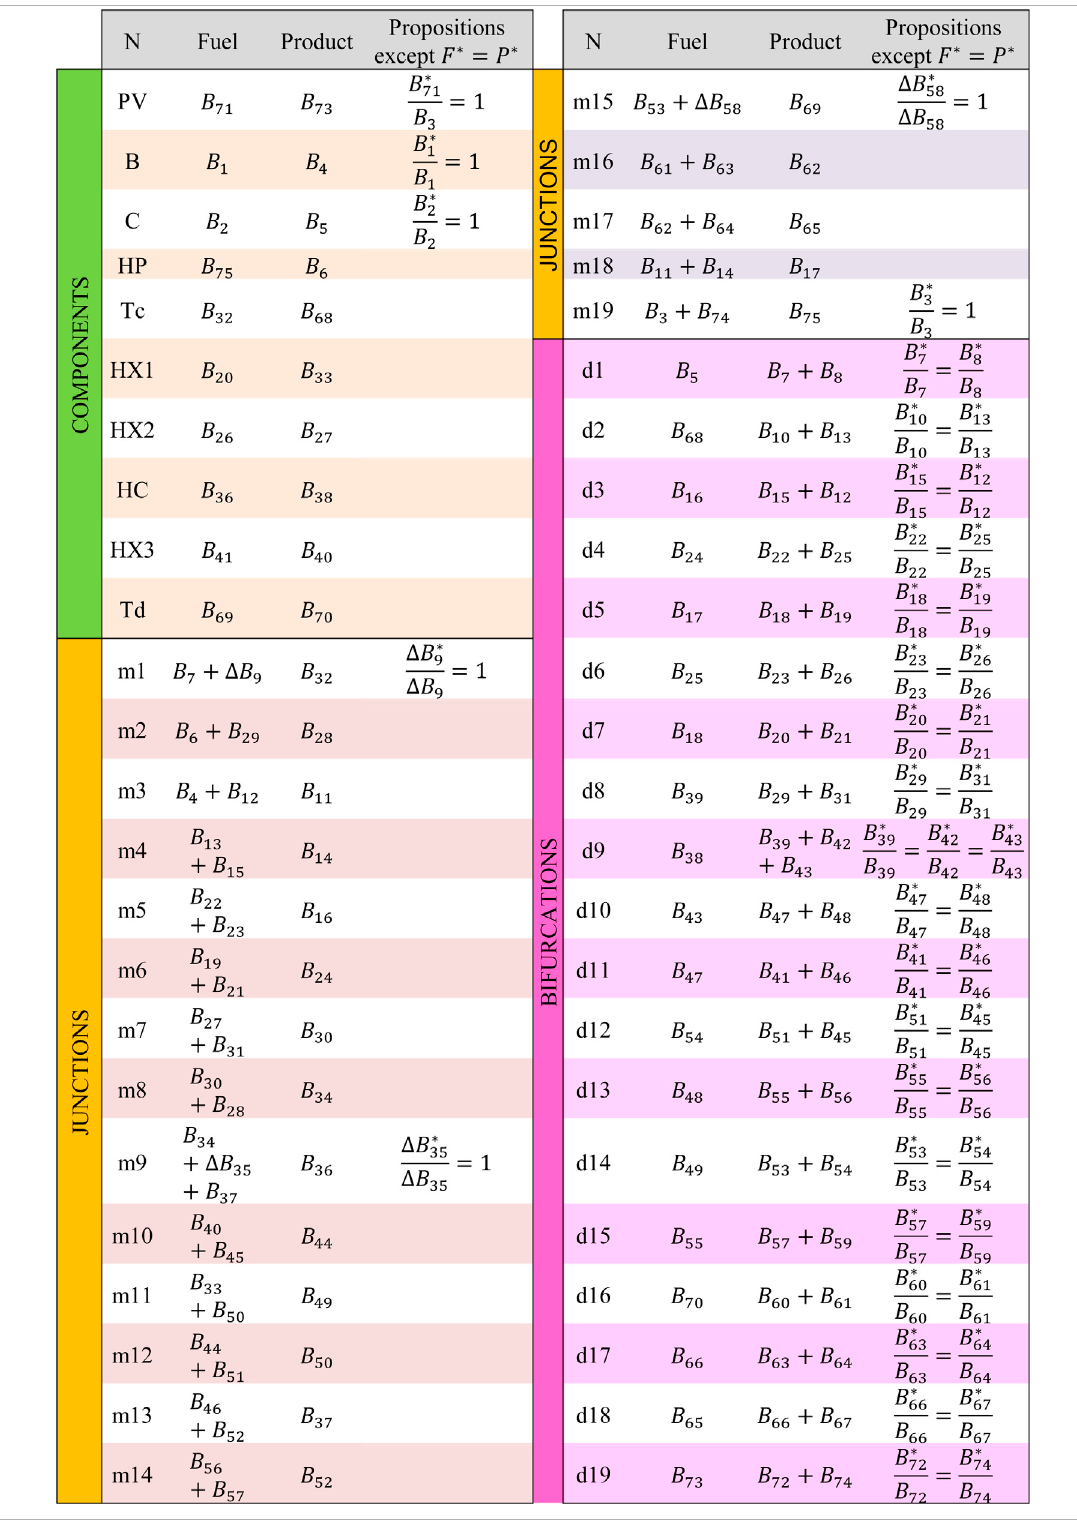
TABLE 1 | Main de fi nition for thermoeconomic matrix